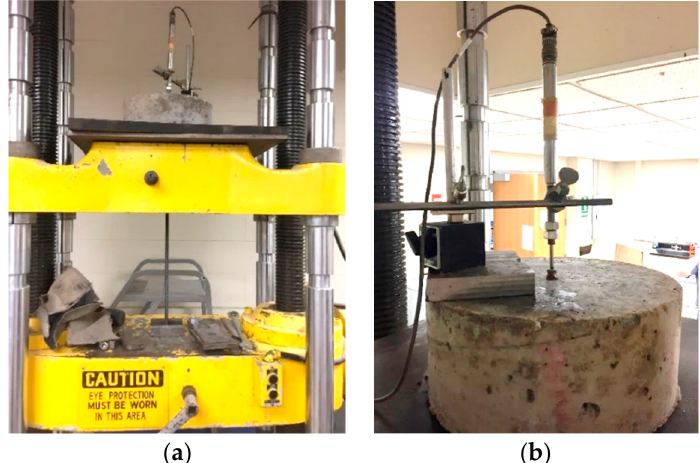
Figure 4. Pull-out test: ( a ) loading set-up; and ( b ) instrumentation.